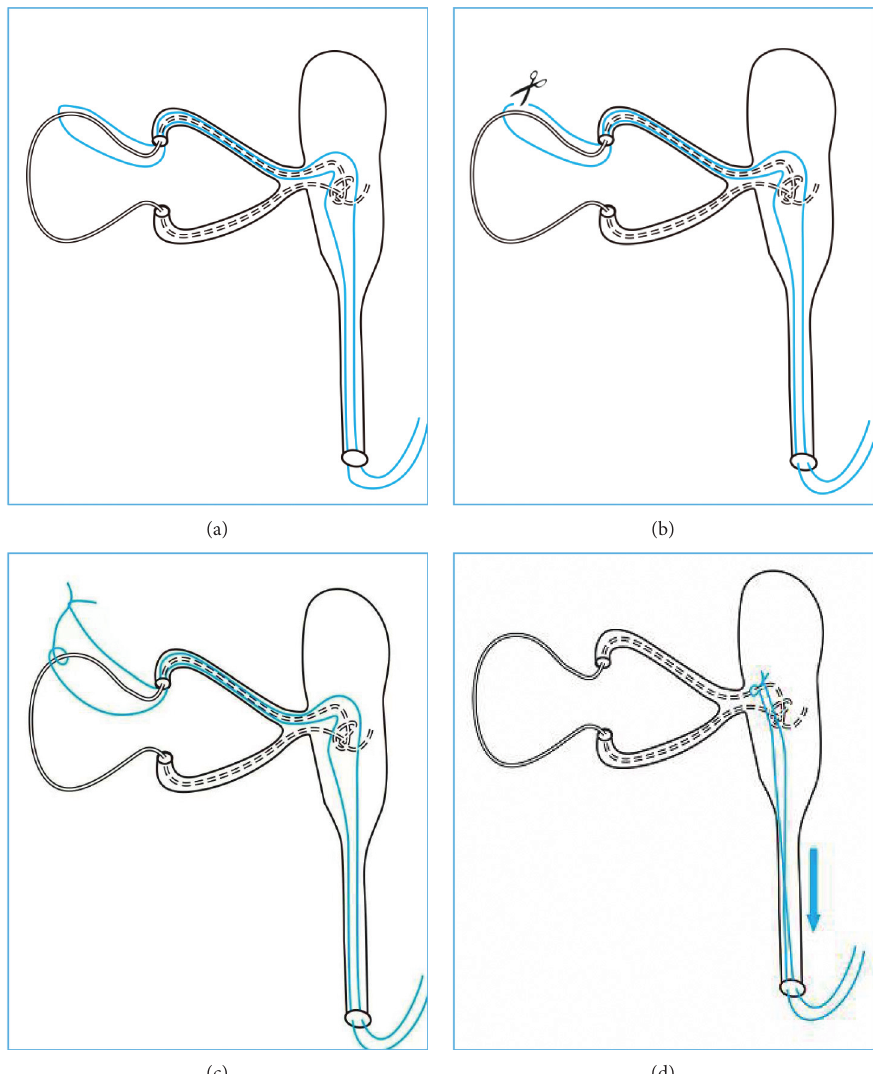
Figure 4: Schematic diagram of repositioning prolapsed silicone tubes. (a) Severe lateral prolapse of the silicone tube at the medial canthus. The distal part of the silicone tube is deep within the nasolacrimal duct or embedded in the lacrimal sac. The middle of a 5-0 nylon suture is pulled through the lacrimal passage retrograde by withdrawing the memory wire probe. (b) The 5-0 nylon suture is cut into two lines from the middle. (c) One line of the nylon is coiled to the silicone tube and tied to another line. This turns into a “lasso” to capture the silicone tube. (d) The distal end of the nylon suture is pulled from the nostril, and the “lasso” slides down from the punctum to the dacryocyst around the silicone tube until it is locked by the knots of the silicone